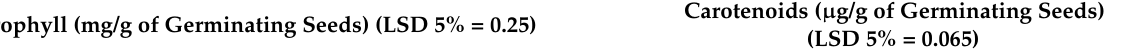
Carotenoids ( µ g/g of Germinating Seeds) (LSD 5% =